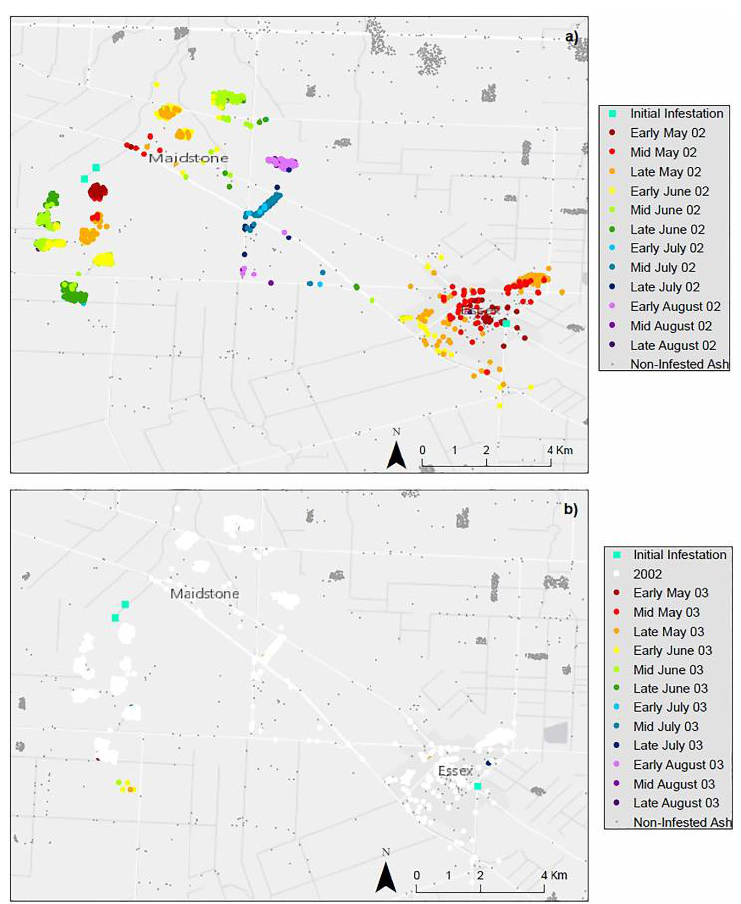
Figure 5. Simulation results of EAB infestation generated for the years ( a ) 2002 and ( b ) 2003 for the Rural-Urban Fringe Landscape Scenario.